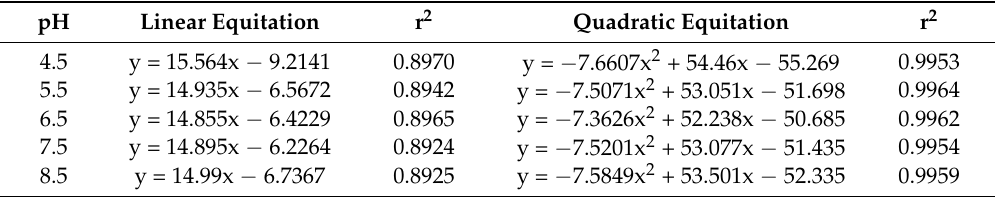
Table A2. Relation between capacity factor ( k ) and log P ow of reference compounds in phosphate buffer.